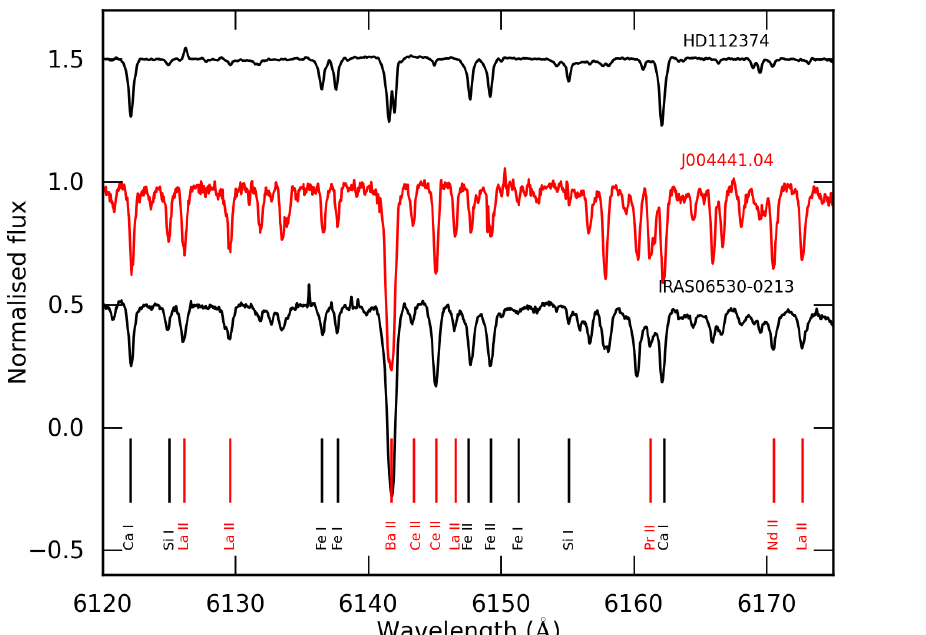
Figure 2. Spectral comparison of three stars with similar temperatures and overall metallicity. Only the top spectrum is from a star without s -process enhancements. In very enriched objects, the s -process lines almost dominate the spectral appearance. Figure from